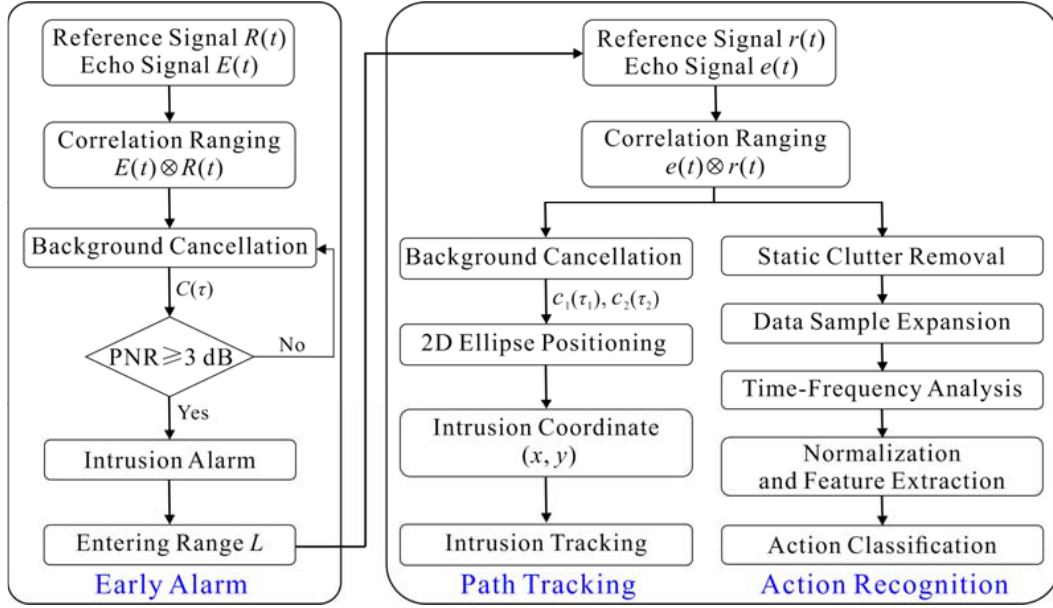
Figure 4. ( a1 ), ( a2 ) Time-domain waveforms; ( b1 ), ( b2 ) power spectrums; ( c1 ), ( c2 ) auto-correlation traces of the 500 Mbps and 2 Gbps random code signals; and ( d ) their cross-correlation trace.